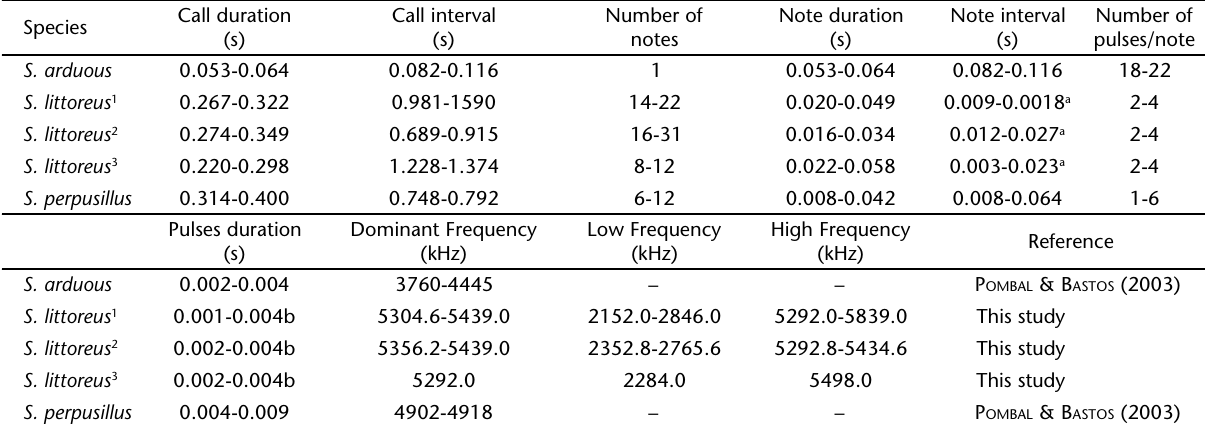
Table II. Comparative table of known aggressive/territorial calls Scinax perpusillus group. Data are given as minimum-maximum.